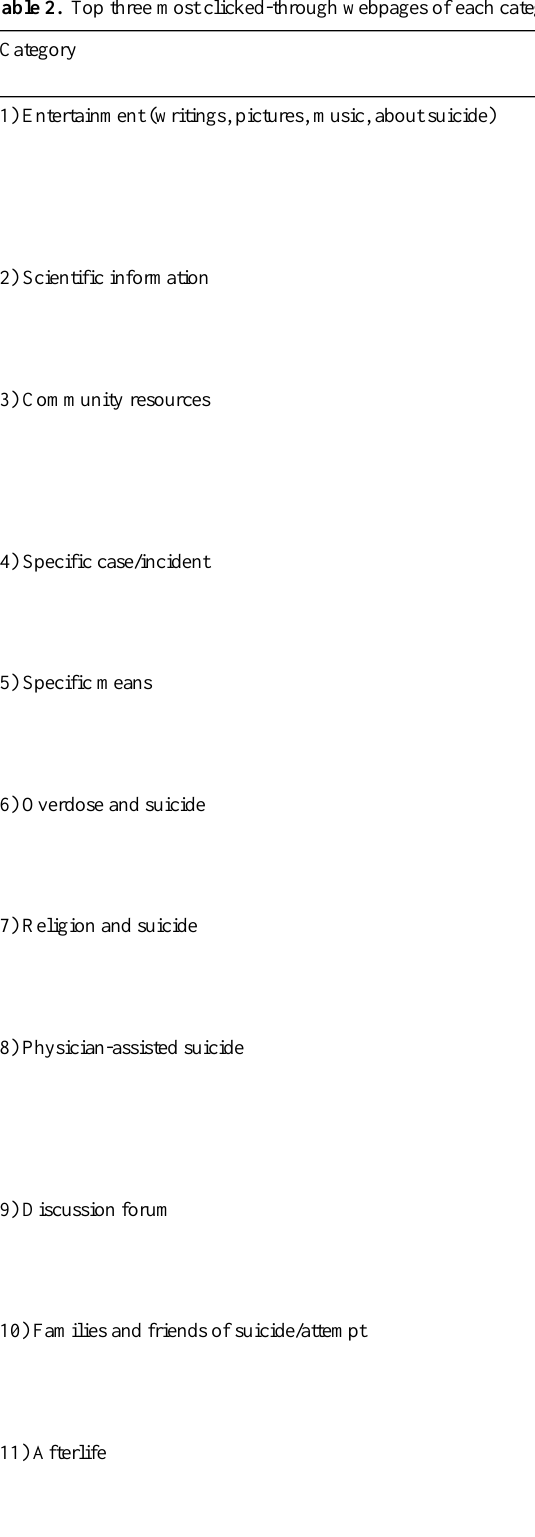
Table 2. Top three most clicked-through webpages of each category, their click-through frequencies, and the number of unique users. 76153http://www.suicidegirls.com1) Entertainment (writings, pictures, music, about